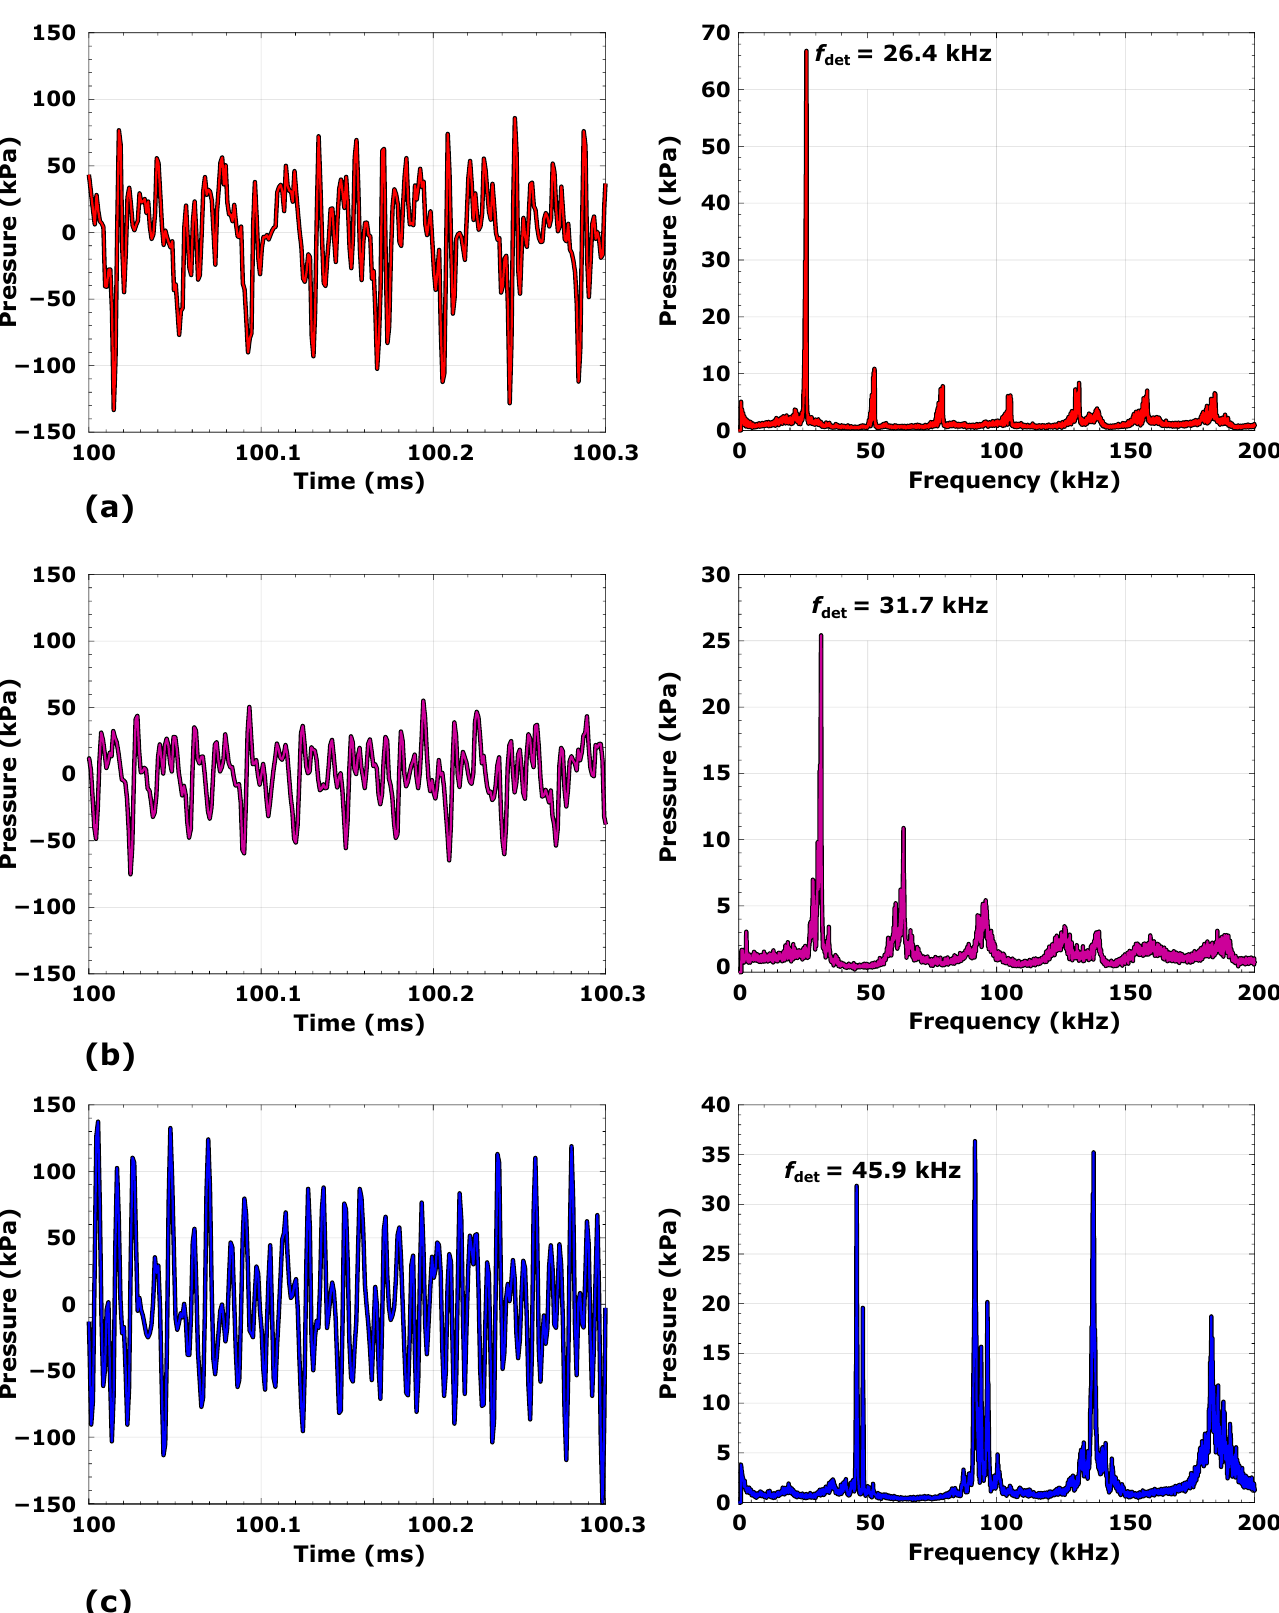
Figure 12. Example temporal pressure histories ( left ) and corresponding frequency spectra ( right ) of the following modal behavior: ( a ) corotating mode for (cid:101) c = 1.00 at m = 4 waves with f det = 26.4 kHz, ( b ) counter-propagating mode for (cid:101) c = 1.00 at m = 6 waves with f det = 31.7 kHz, and ( c ) counter-propagating mode for (cid:101) c = 2.40 at m = 8 waves with f det = 45.9